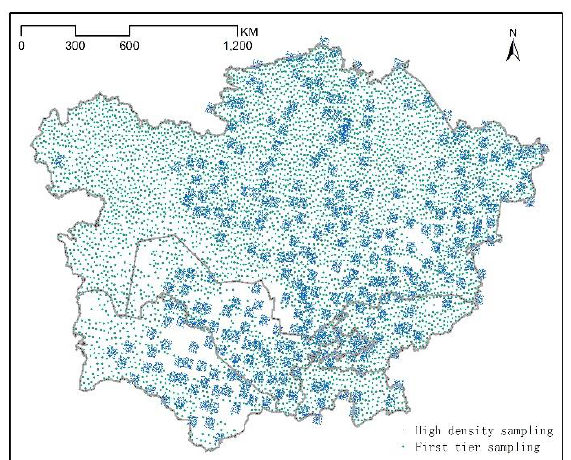
Figure 3. Sampling scheme for accuracy